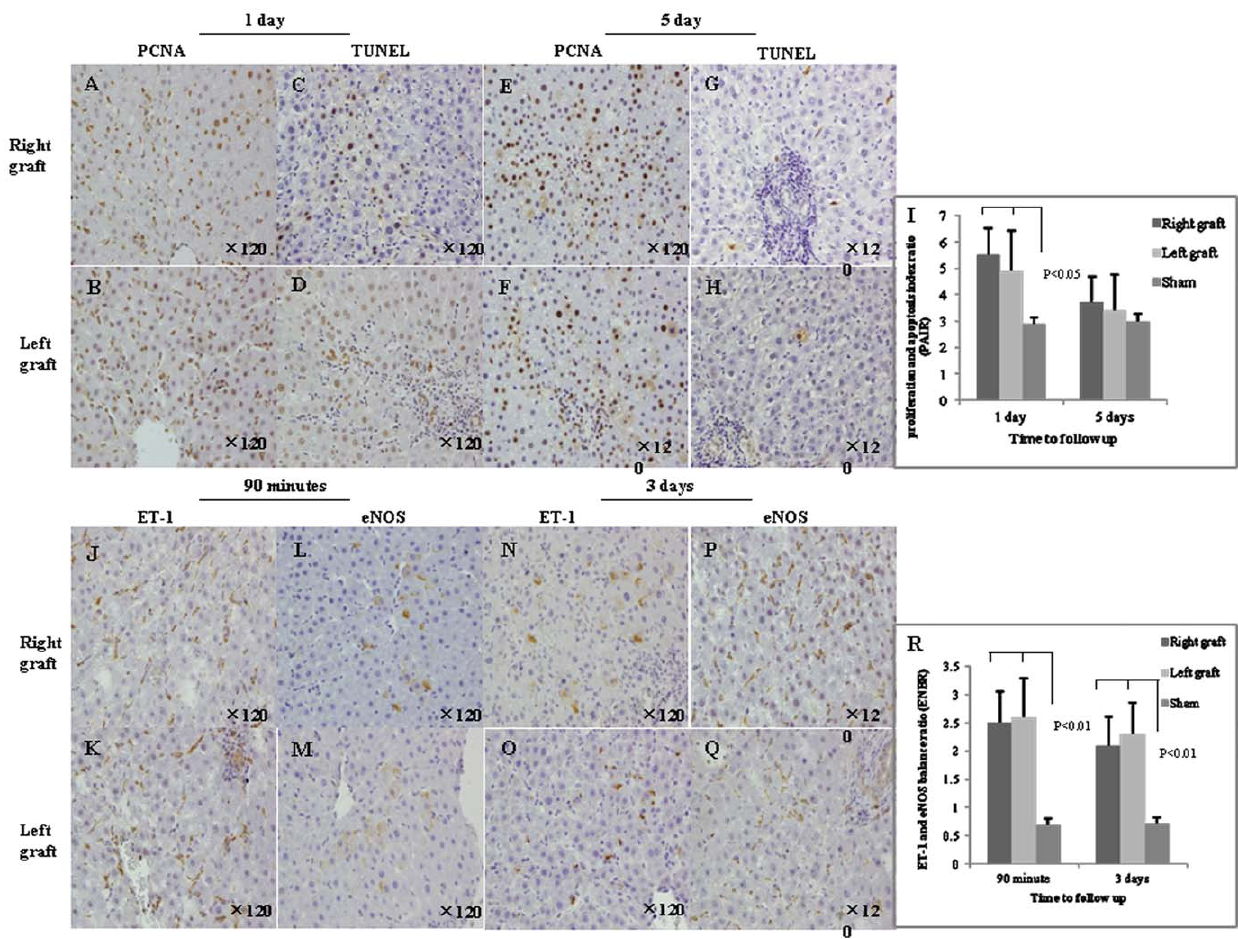
Figure 4. Proliferation and apoptosis of Hepatocyte and contraction and relaxation of endothelium by immunostaining. A and B, PCNA staining in right and left grafts 1 day after reperfusion. C and D, TUNEL staining in right and left grafts 1 day after reperfusion. E and F, PCNA staining in right and left grafts 5 day after reperfusion. G and H, TUNEL staining in right and left grafts 1 day after reperfusion. I, Proliferation and apoptosis index ratio was significantly increased in right and left graft 1 day after reperfusion (p , 0.05), compared to the sham group. No difference was found between right and left grafts. J and K, ET-1 staining in right and left grafts 90 minutes after reperfusion. L and M, eNOS staining in right and left grafts 90 minutes after reperfusion. N and O, ET-1 staining in right and left grafts 3 days after reperfusion. P and Q, eNOS staining in right and left grafts 3 days after reperfusion. R, ET-1 and eNOS balance ratio in right and left grafts were dramatically increased 90 minutes and 3 days after reperfusion compared to the sham group (p , 0.01). No difference was found between right and left grafts. Brown stained cell is positive cells. ET-1, endothelin-1; eNOS, endothelial NO-synthase; ENBR, ET-1 and eNOS balance ratio; PAIR, proliferation and apoptosis index ratio; PCNA, proliferation cell nuclei antigen; TUNEL, terminal deoxynucleotidyl transferase-mediated nick-end